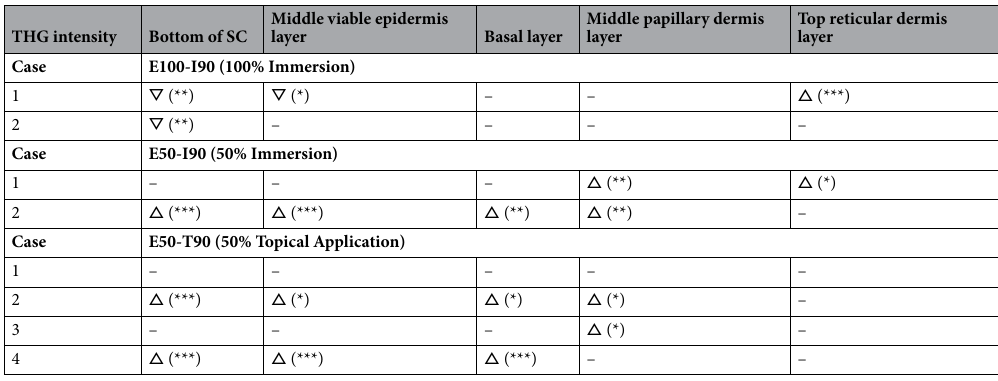
Table 2. Statistical analysis result on the THG intensity variation after the glycerol application. −: no significant difference, △ : Increased significantly, ▽ : Decreased significantly, * P < 0.05, ** P < 0.01, *** P < 0.001.